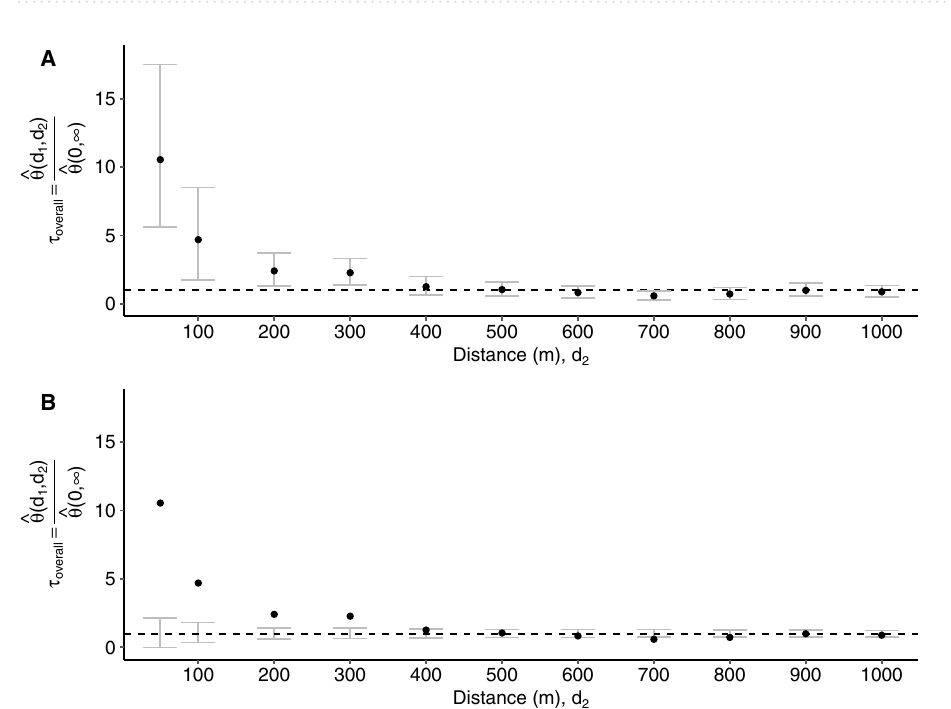
Figure 2. Spatial distribution of ( A ) enrolled dengue cases by serotype across Yogyakarta City, ( B ) the cluster-aggregate test-positive fraction, i.e., the proportion of enrolled dengue cases among the total number of individuals enrolled in each cluster, and ( C ) kernel smoothing estimates of the spatially-varying test-positive fraction. Each map includes participants enrolled from January 2018 through March 2020. The borders in each map represent the cluster boundaries for the AWED trial. Clusters are labelled with their numerical code in panel B and their intervention status in panel C. Points represent the geolocated households of virologically confirmed dengue cases. Areas with darker shading in panels B and C have a higher proportion of dengue cases among enrolled AWED participants than areas with lighter shading. Smoothing bandwidth was selected by cross-validation.